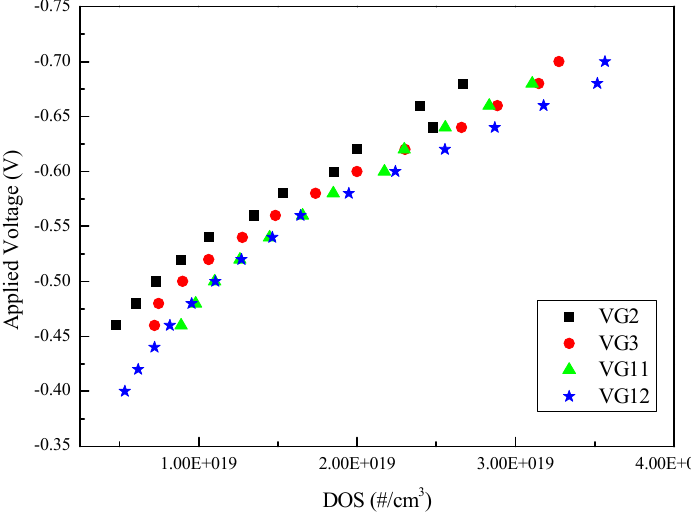
Figure 6. Energetic distribution as a function of Density of State (DOS) for devices including VG2 ‐ C8, VG3 ‐ C8, VG11 ‐ C8 and VG12 ‐ C8 dyes.